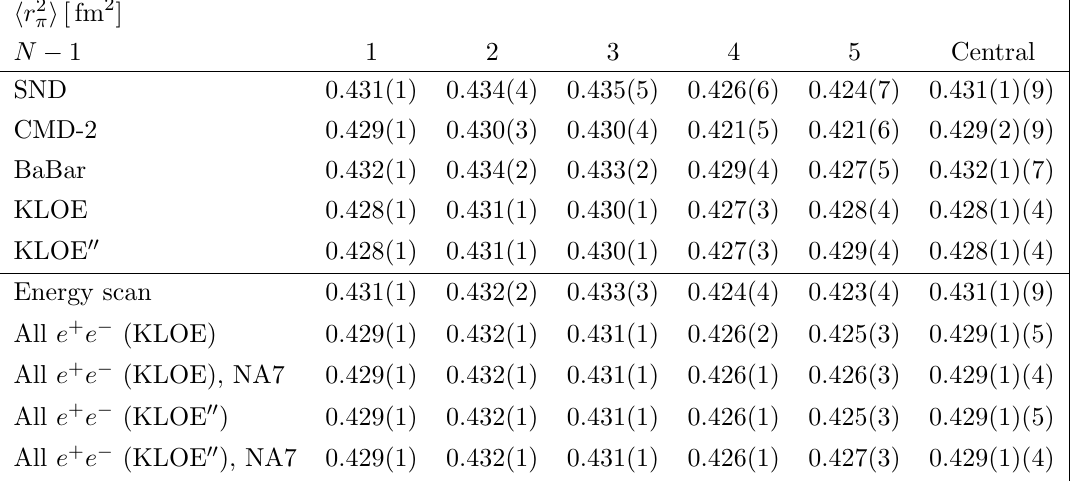
Table 13. Charge radius corresponding to the (cid:12)ts to single time-like experiments and to com- binations of data sets. The errors in the (cid:12)rst (cid:12)ve columns are the (cid:12)t uncertainties, in(cid:13)ated by p (cid:31) 2 = dof. The results in the last column correspond to N (cid:0) 1 = 1. The (cid:12)rst error is the in(cid:13)ated (cid:12)t uncertainty, the second error is the total uncertainty (which includes the variation N (cid:0) 1 = 1 : : :